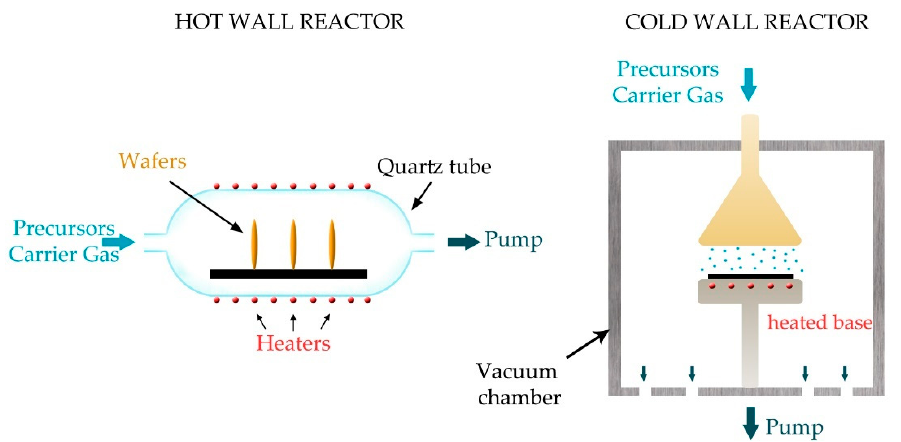
Figure 8. Hot-wall and cold-wall CVD reactors.